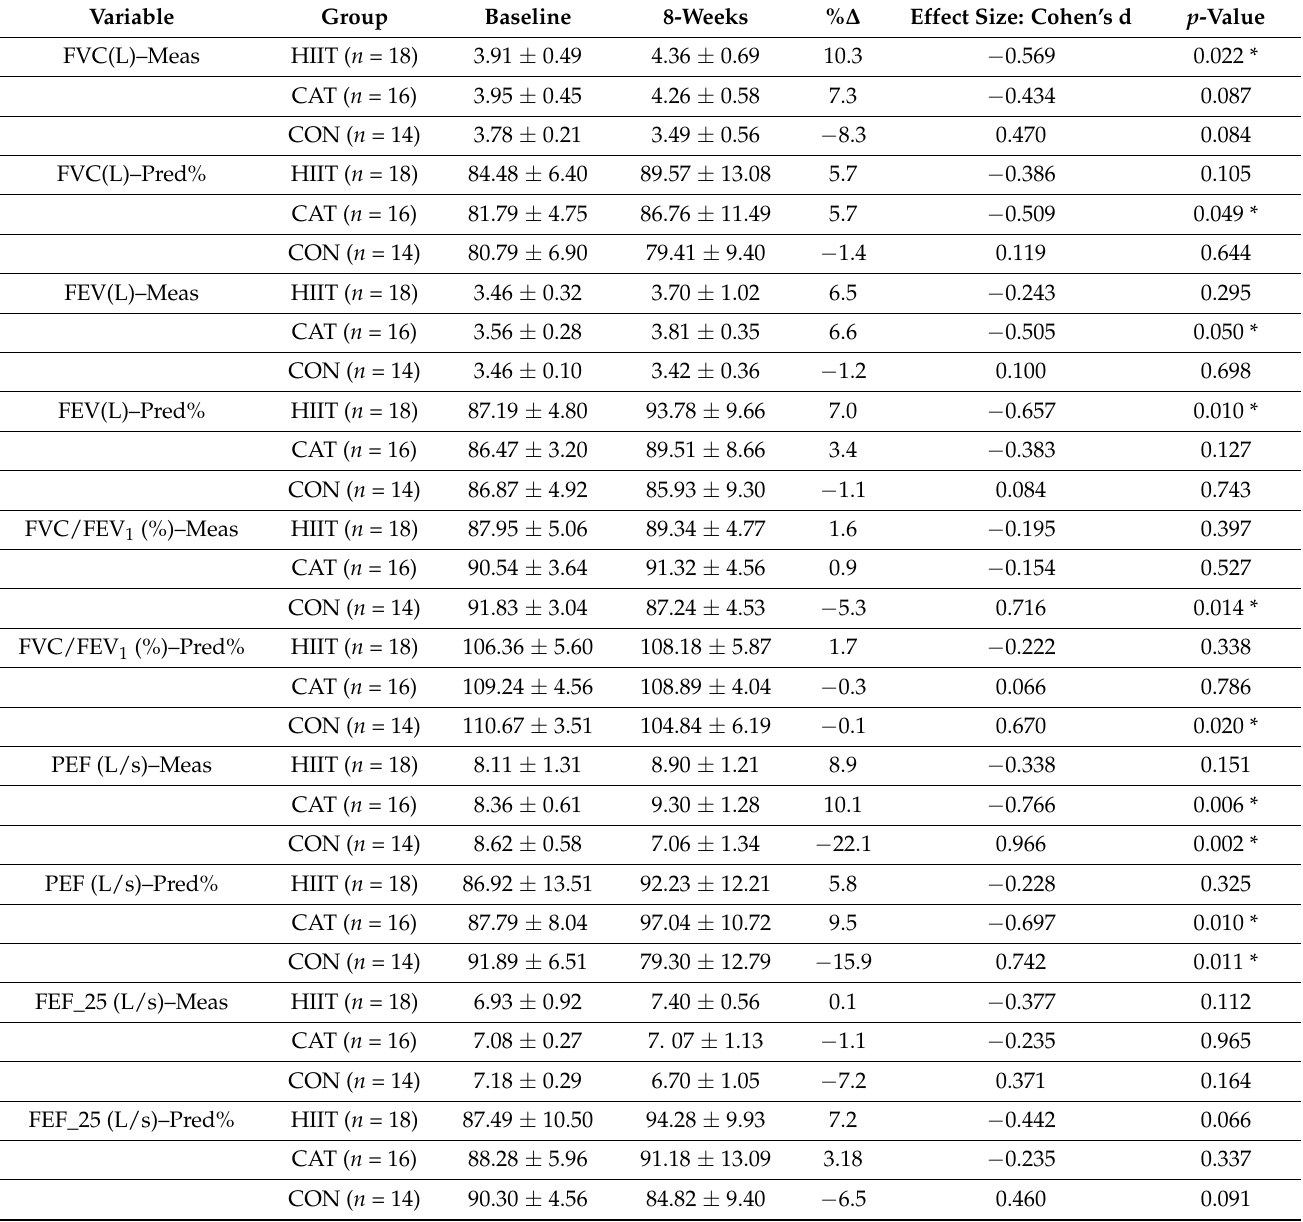
Table 4. Intra-group comparisons of lung function variables (forced vital capacity, forced